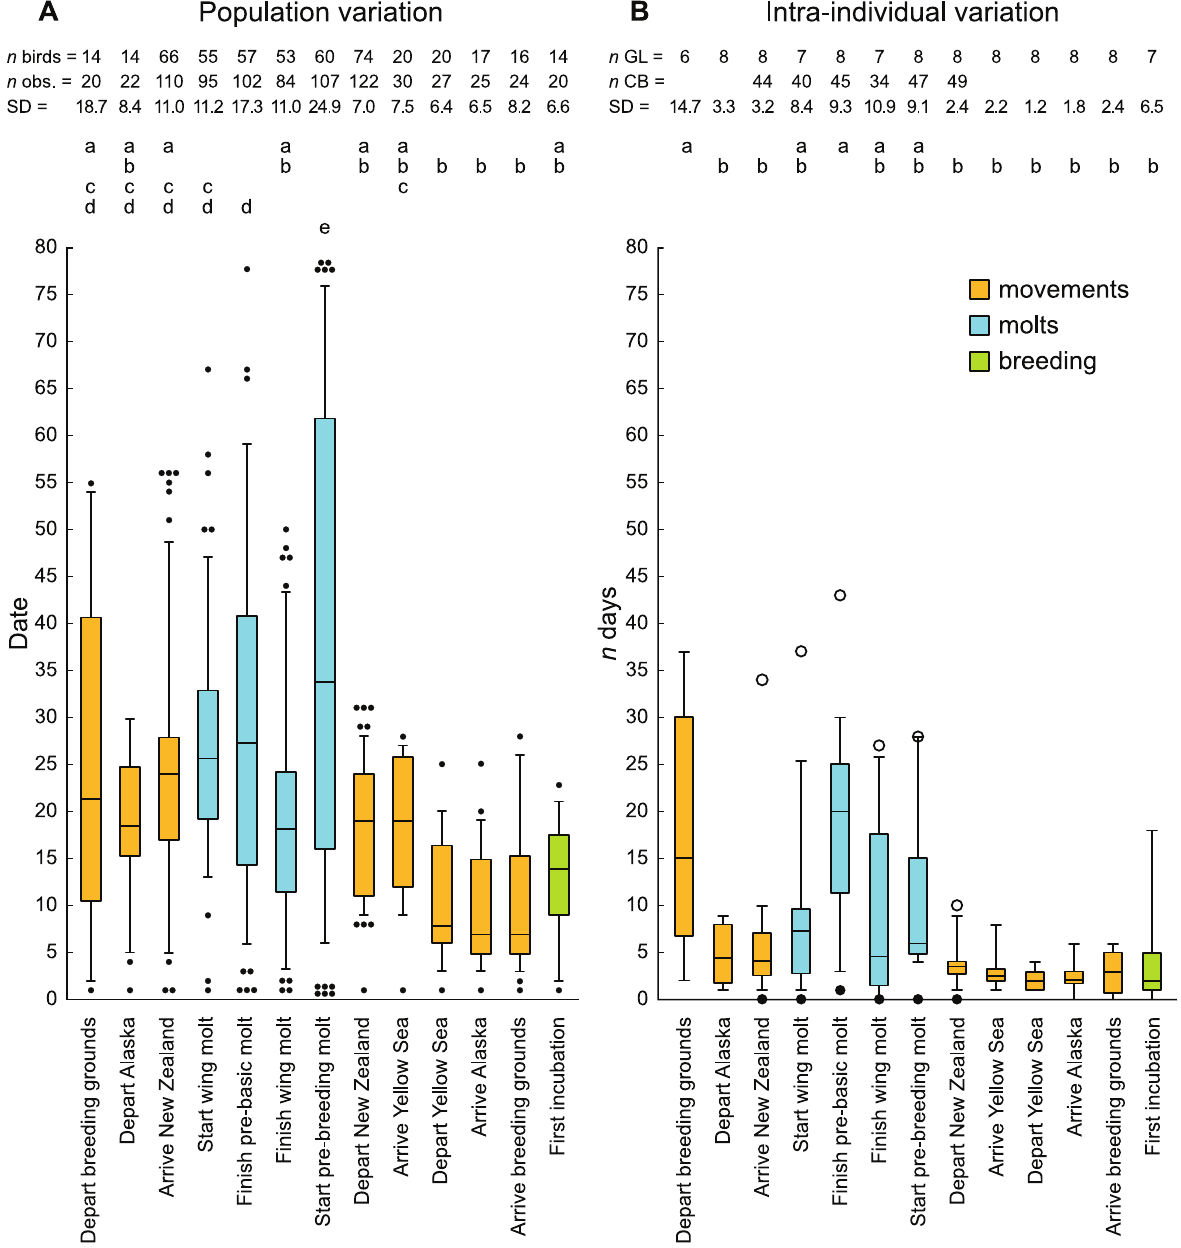
Figure 2. Population and individual variation in timing throughout the annual cycle of bar-tailed godwits. Stages ( x -axis) are in chronological order from left to right, starting with dispersal from breeding grounds (see Figure 1). (A) Distribution of all observations during March 2008 – March 2010, standardized by date (day 1= earliest observation for each stage). Data are derived from color-banded (New Zealand only) or geolocator-tracked (outside New Zealand) godwits. Boxplots indicate median and 25 th and 75 th percentiles; whiskers indicate 5 th and 95 th percentiles; filled circles indicate more extreme values; overlapping points are offset for clarity. Standard deviation (SD) is shown above. (B) Intra-individual variation in timing (difference between dates in successive years) for geolocator-tracked godwits (GL; sample sizes=individuals observed in two years). Boxplots indicate median and 25 th and 75 th percentiles; whiskers indicate entire range of values; SD is shown above. Circles indicate greatest (open) and least (filled) within-individual differences in the larger sample of color-banded (CB) birds (New Zealand only; sample sizes shown). Letters indicate significant differences in Kruskal-Wallis test followed by Dunn’s post-hoc comparison.